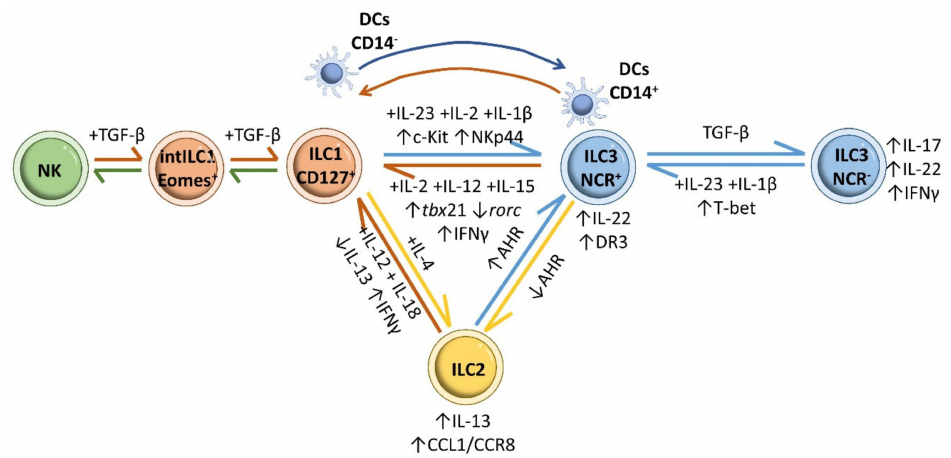
Figure 8. ILC plasticity. Prolonged exposure of ILC3s to the type 1 polarizing cytokines IL-2, IL-12 and IL-15 induces their conversion to CD127 + ILC1 cells, with downregulation of RORC, upregulation of TBX21 and IFN- γ production. Reverse differentiation of ILC1s to ILC3s is driven by IL-23, IL-2 and IL-1 β . Moreover, CD14 − DCs mediate the transformation of ILC1s into ILC3s in vivo by promoting synthesis of c-kit and NKp44 in ILC1s, whereas CD14 + DCs are implicated in the transformation of NCR + ILC3s into ILC1s. IL-23 and IL-1 β stimulation induces the conversion of NCR − ILC3s into the more proinflammatory NCR + ILC3 subset through T-bet upregulation. The reverse differentiation from NCR + ILC3s to NCR − ILC3s is promoted by high levels of TGF- β . Removal of AHR enriches the effect of intestinal ILC2s, whereas increased AHR expression restrains ILC2 function while increasing ILC3 function. Treatment with IL-12 and IL-18 reduces IL-13 expression in ILC2s, shifting them to an IL-13 − IFN- γ + ILC1 phenotype. ILC2-derived ILC1s can revert to ILC2s in response to IL-4. NK cells (CD49a − CD49b + Eomes + ) differentiate into intermediate type 1 innate lymphoid (intILC1, CD49a + CD49b + Eomes + ) populations and ILC1s (CD49a + CD49b − Eomes int ) in response to cytokine and TGF- β